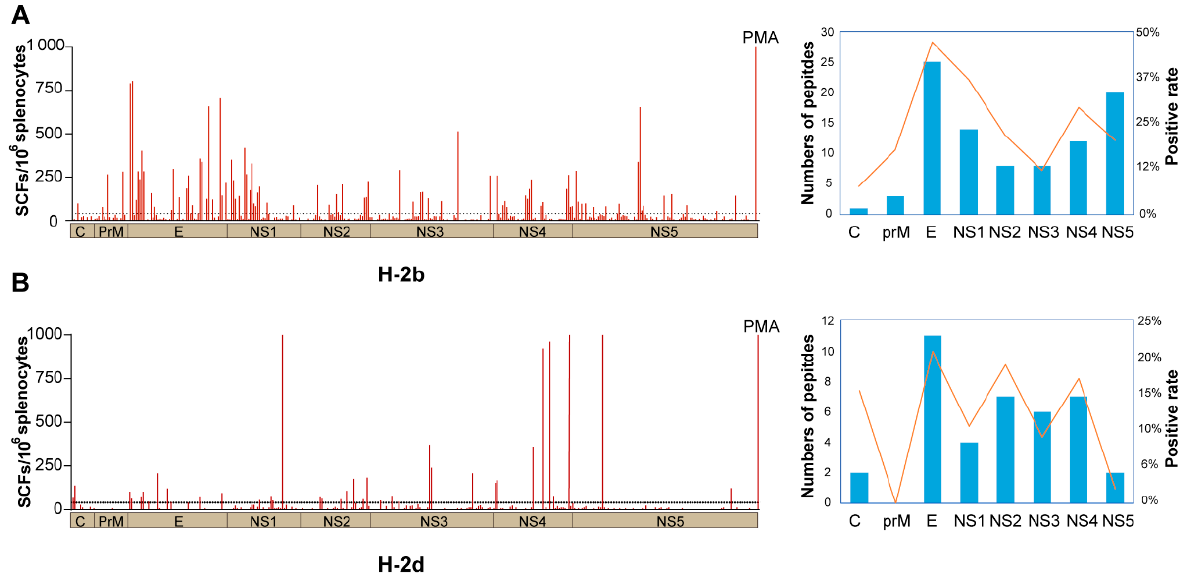
Figure 3. Mapped peptides according to location in the ZIKV polyprotein of H-2 b and H-2 d mice. Wild-type C57BL/6 and BALB/c mice were infected with 10 4 FFU of ZIKV, splenocytes were har- vested at 14 d.p.i. and stimulated with the indicated matrix peptide pools. A total of 364 peptides were screened by IFN- γ -ELISPOT assays, with PMA as a positive control. ( A , B ) Left shows SFCs of 364 peptides distributed in the ZIKV polyprotein in H-2 b ( A ) and H-2 d ( B ) mice ( n = 3 per peptide). Right shows the number of positive peptides for each protein, SFCs ≥ 40 in H-2 b means positive. 3.3. The CD8+ and CD4+ T Cell Recognition Features of the ZIKV Antigens To further validate the immune reaction and cytokines induced by these above-positive peptides, splenocytes were stimulated with a positive peptide individually and the IFN- γ , TNF- α , and IL-2 secreting of the antigen-specific CD8+ and CD4+ T cells was detected. For H-2 b mice, 3 peptides presented positive for three cytokines of IFN- γ /TNF- α /IL-2 in CD8+ T cells and 13 peptides in CD4+ T cells (Figure 4). Peptides such as E 640-659 and NS5 2955-2973 in CD8+ T cells performed strongly, producing three cytokines. For H-2 d mice, six peptides presented positive for three cytokines in CD8+ T cells and three peptides in CD4+ T cells (Figure S1). Peptides such as NS1 1054-1071 and NS4 2349-2367 performed strongly, with three cytokines producing in CD8+ T cells. Other peptides performed immune activation with production of two or individual cytokines. Taken together, these results demonstrate a distinct CD8+ and CD4+ T cell recognition of the epitope spectrum of